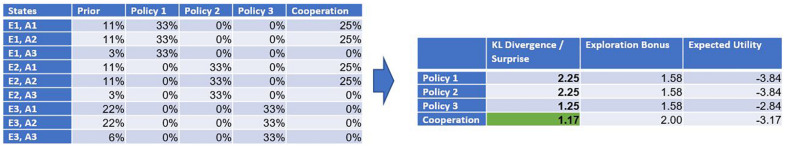
(Left Table) Summary of all probability distributions used in the situation. (Right Table) The resulting risk of each policy is calculated using the Kullback-Leibler Divergence DKL. The agent chooses the policy that has the smallest divergence, meaning that the distribution over the attainable states is closest to the agent’s preferences encoded in the prior distribution. In the situation described, the cooperative policy, which excludes the hostile actions for both agents, minimizes the risk for the Ego agent. Since the Alter agent is a copy of the Ego agent, it is likely that a cooperation is agreed upon.